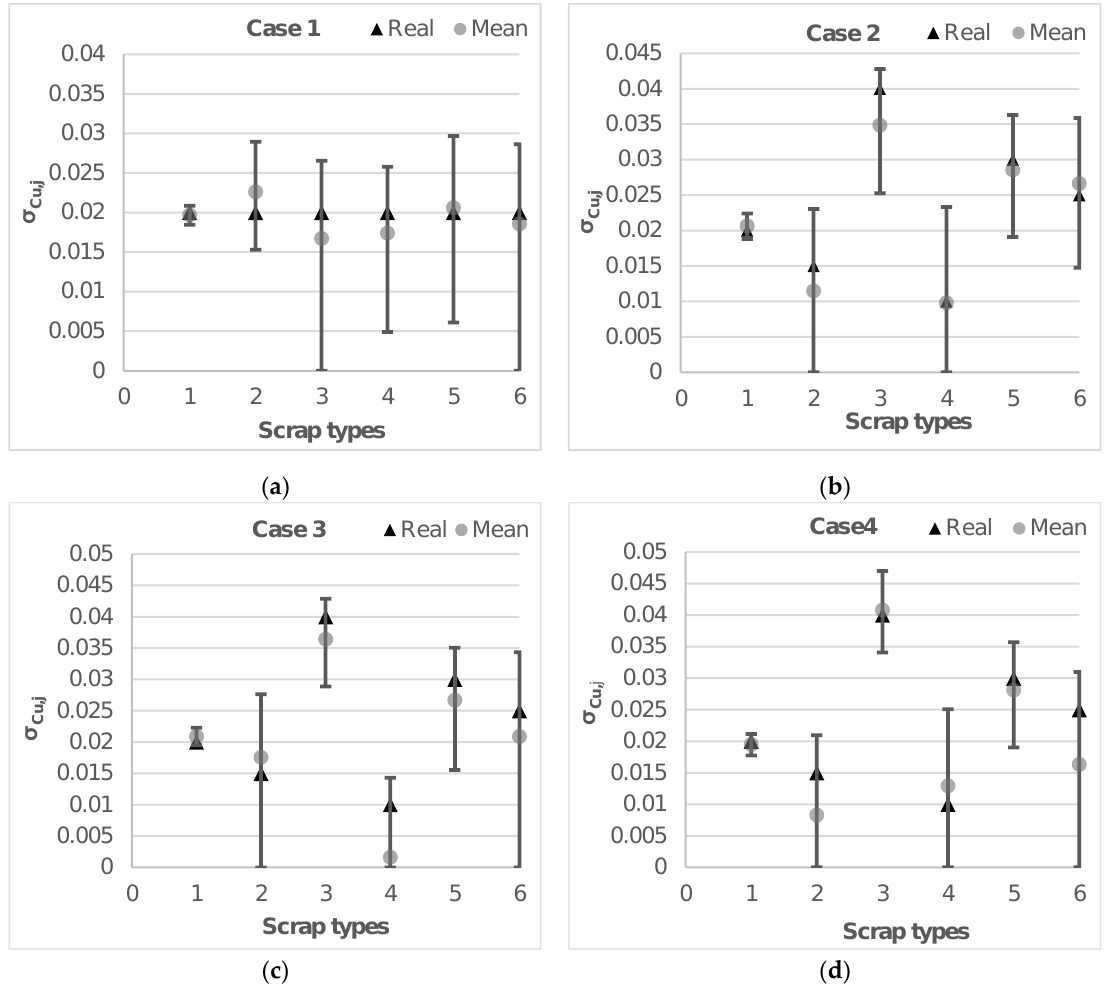
Figure 2. Estimated mean standard deviations for concentration of Cu ( σ Cu ) with a 95% confidence interval in scrap types,